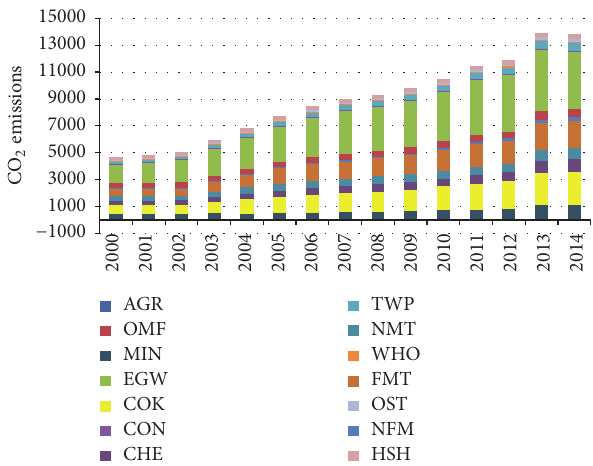
Figure 2: CO 2 emissions of various sectors in China during 2000– 2014.